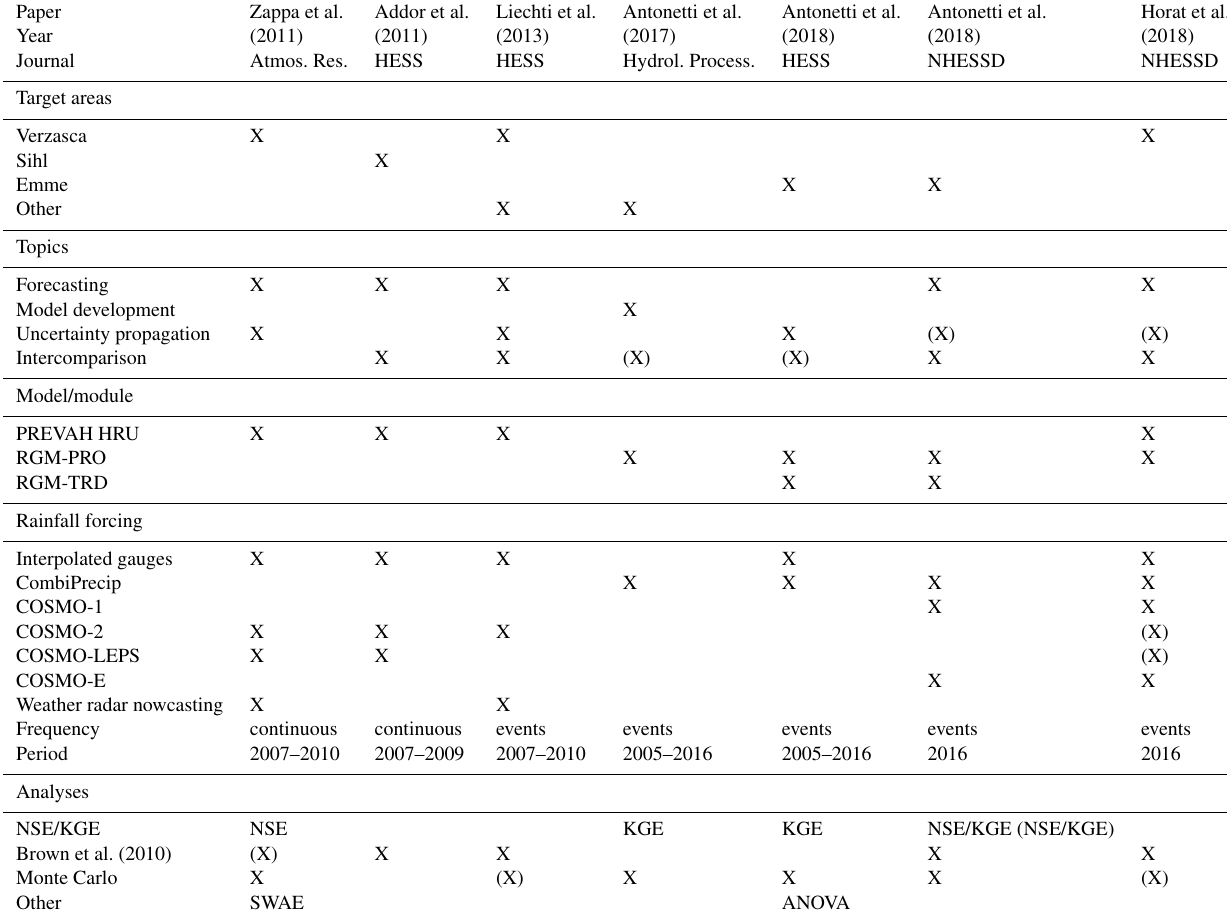
Table 1. Overview of previous own work on the topics of the paper. Prior and current applications are classified according to the target area, the models used, the available forcing and the analyses performed. NSE is the Nash–Sutcliffe efficiency. KGE is the Kling–Gupta efficiency. SWAE is the sum of weighted absolute errors. ANOVA is the analysis of variance. Brown et al. (2010) is given as a benchmark paper for the verification of ensemble hydrological